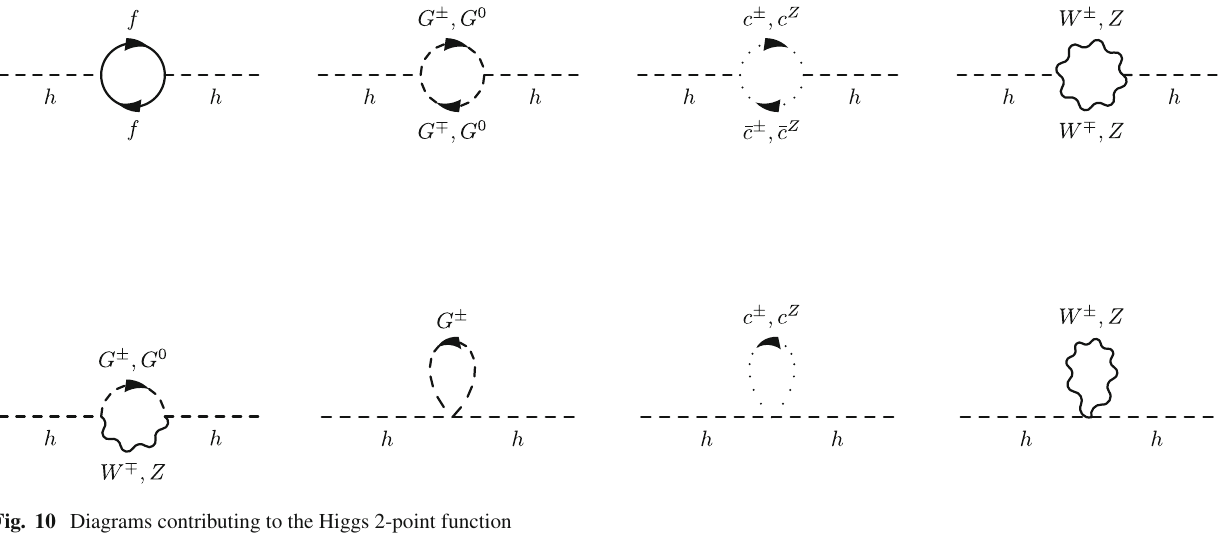
Fig. 10 Diagrams contributing to the Higgs 2-point function